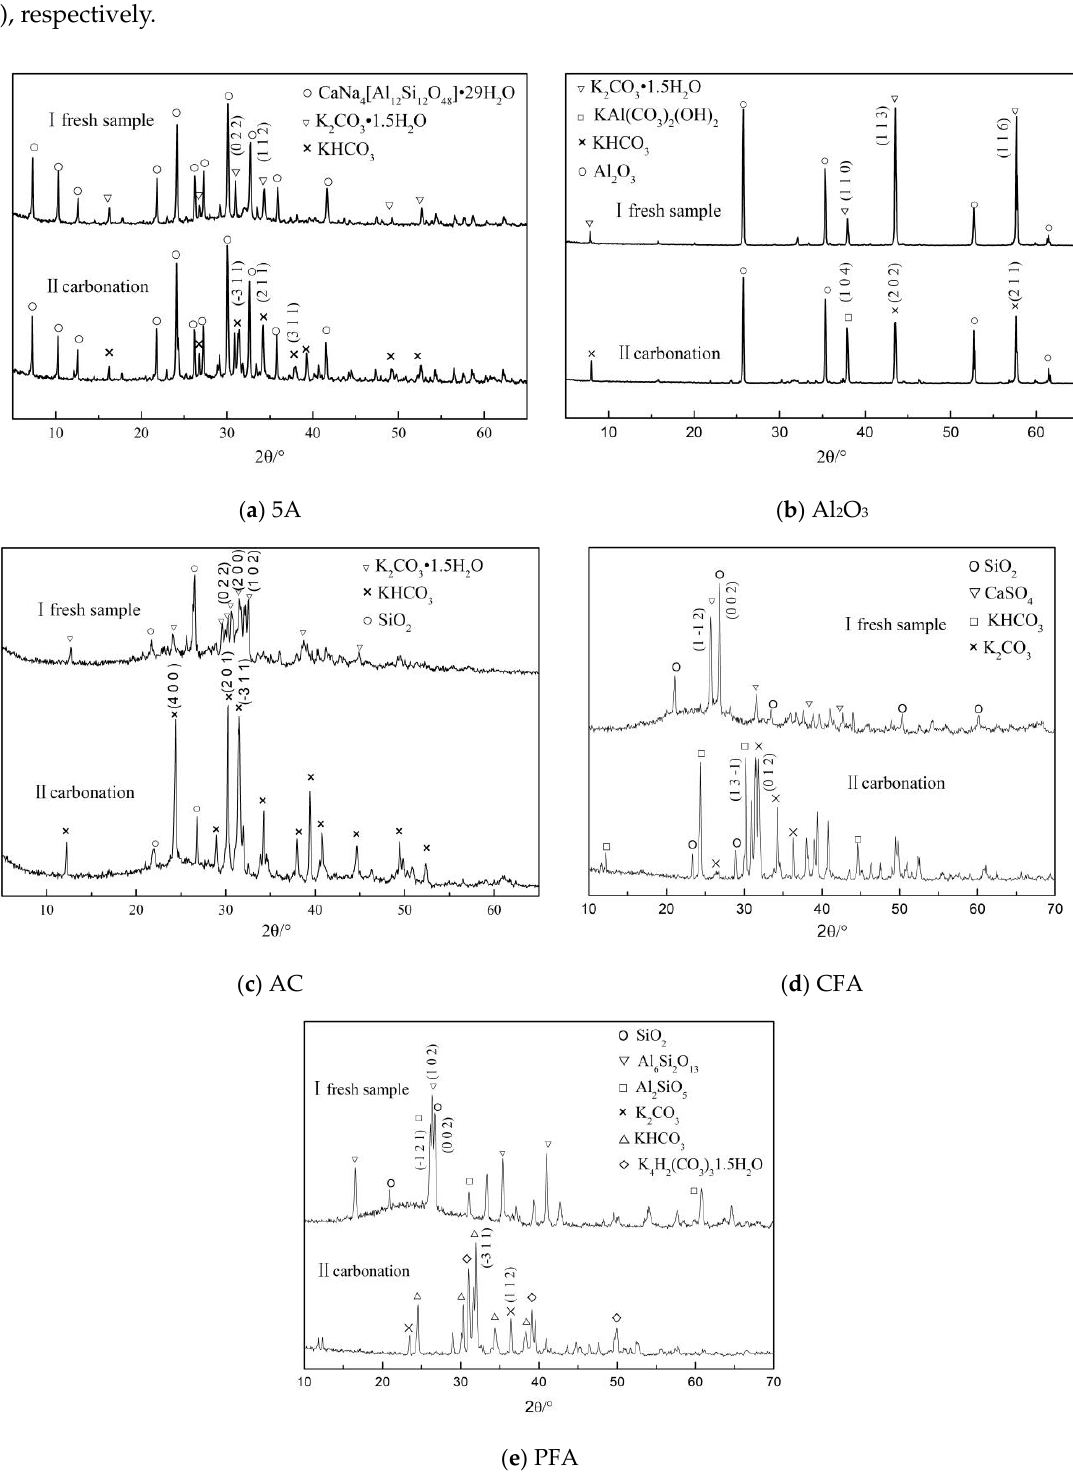
Figure 10. XRD diffraction pattern before and after carbonation of different adsorbents. ( a ): The XRD result of 5A; ( b ): The XRD result of Al 2 O 3 ; ( c ): The XRD result of AC; ( d ): The XRD result of CFA; ( e ): The XRD result of PFA.